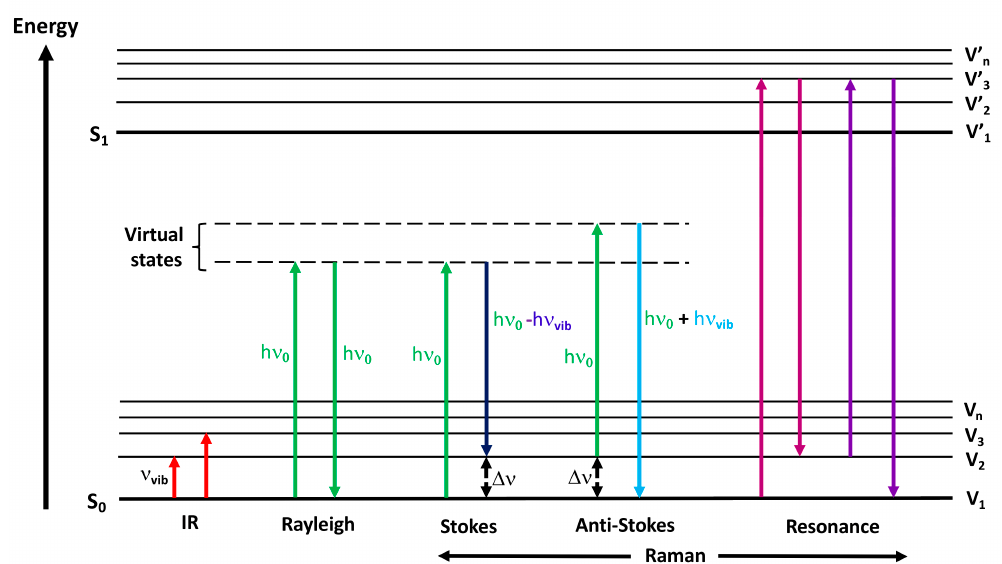
Figure 1. Jablonski energy diagram showing the transitions involved during infrared absorption, Rayleigh, Raman Stokes, anti-Stokes and Resonance Raman scattering. The vibrational states (V n ) of a molecule in the ground electronic state (S 0 ) can be probed either by directly measuring the absolute frequency (IR absorption) or the relative frequency or Raman shift (Stokes and anti-Stokes) of the allowed transitions. Resonance Raman also involves the vibrational states (V’ n ) of the excited electronic state (S 1 ). H ν 0 = incident laser energy, h ν vib = vibrational energy, ∆ν = Raman shift and ν vib = vibrational frequencies.